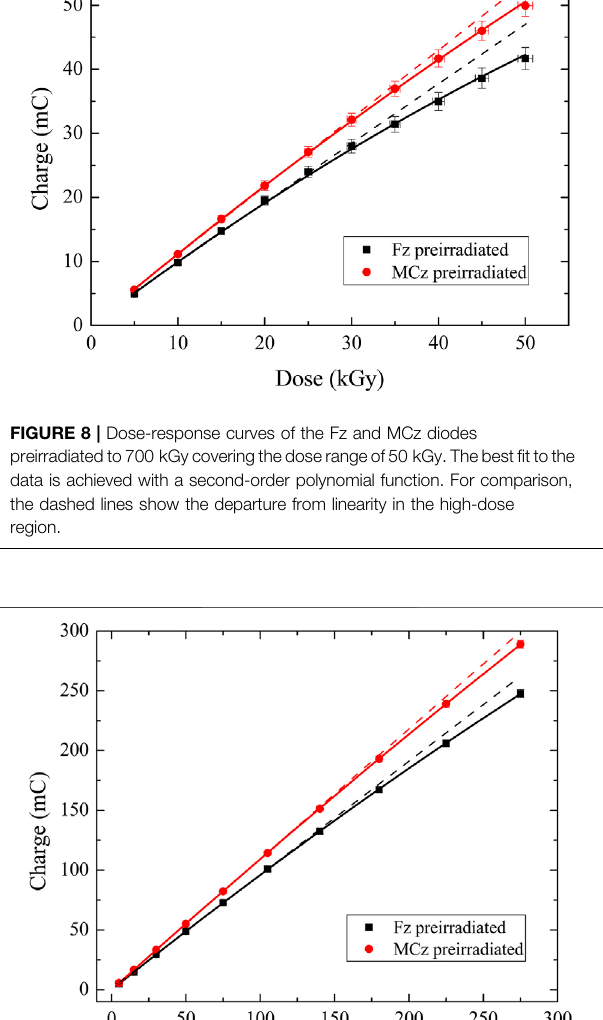
FIGURE 7 | Current signals delivered by the MCz and Fz diodes preirradiatedto700 kGy.Dosesspanfrom5to50 kGyinincrementalstepsof 5 kGy under dose rates of 2.39 kGy/h (MCz) and 2.33 kGy/h (Fz). Instrumental uncertainties in the current measurements are smaller than the size of the symbols.